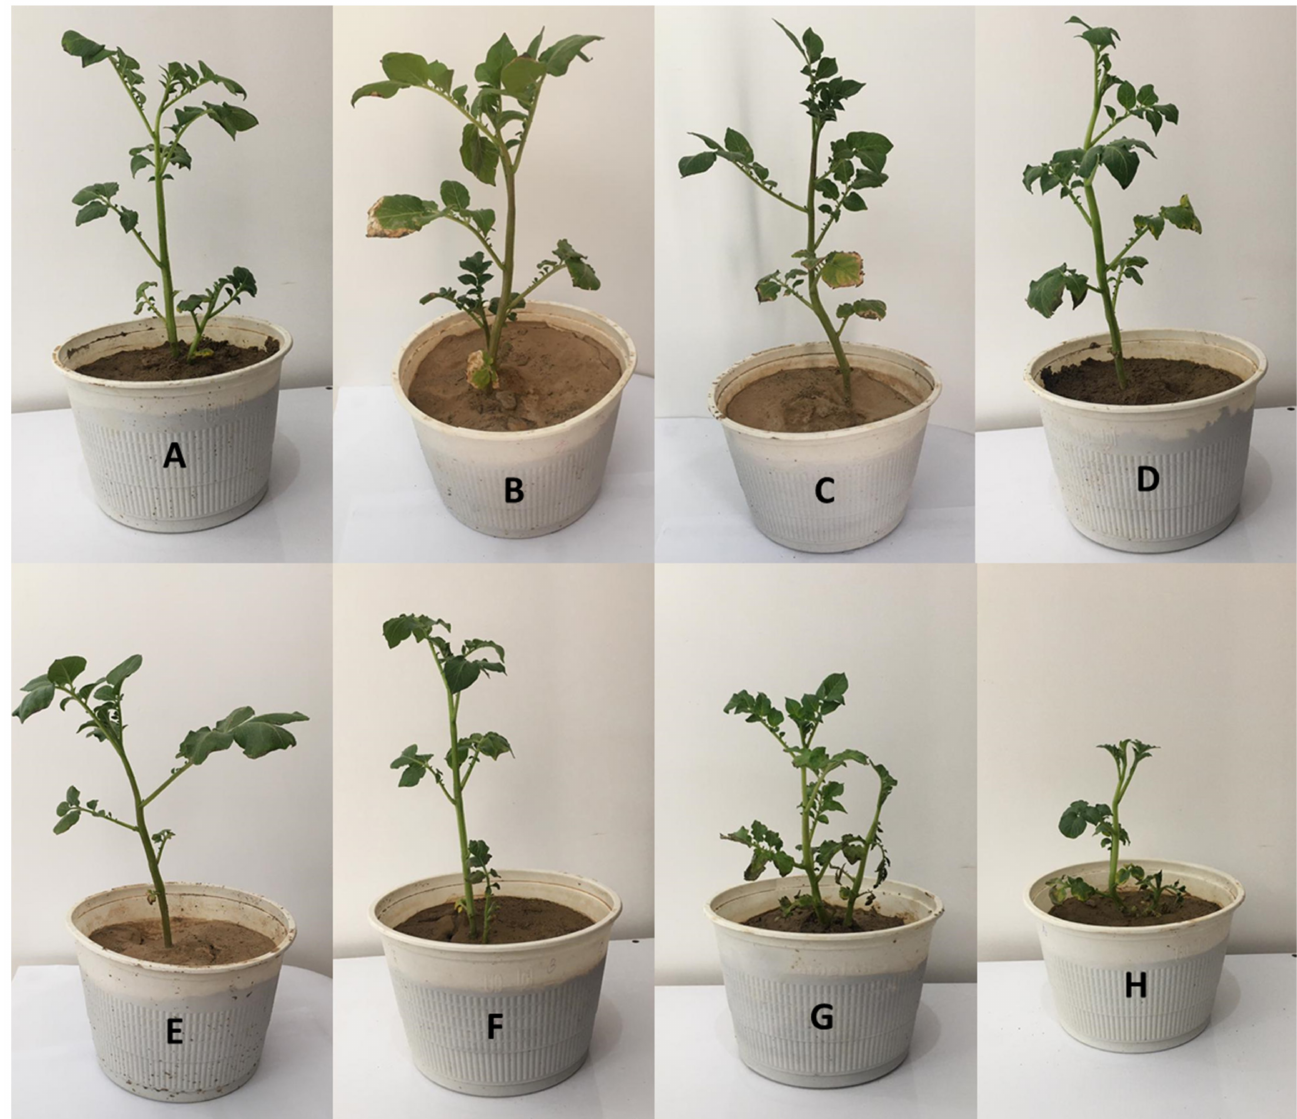
Figure 4. The effect of bacterial strain Pseudomonas chlororaphis VUPF506 and its ALG–WP–CNT microcapsules on the control of Rhizoctonia solani in potato plants. ( A ): Spray drying-based microcapsules + pathogen, ( B ): extrusion-based microcapsules + pathogen, ( C ): emulsification-based microcapsules + pathogen, ( D ): microcapsules without bacterial strain + pathogen, ( E ): P. chlororaphis VUPF506, ( F ): P. chlororaphis VUPF506 + pathogen, ( G ): control, ( H ):